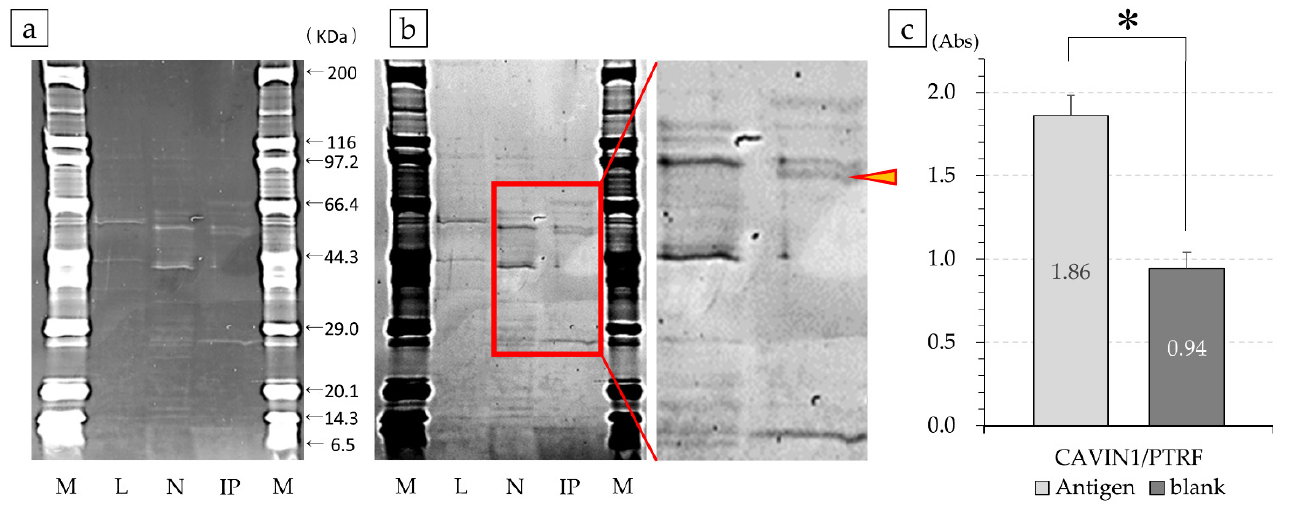
Figure 5. SDS-PAGE of the antigen–antibody complex and confirmation analysis with purified protein. Using immunoprecipitation through magnetic beads, the band incubated separately with the antibody was detected. Number 12 ( a ); M, marker; L, cell lysate solution; N, negative; IP, positive samples recovered by immunoprecipitation. Figure 5a is inverted in black and white and shows an enlarged view of more specific bands. This band (yellow arrowhead) was analyzed by Liquid chromatography-mass spectrometry (LC/MS) ( b ). The reactivity of commercially available CAVIN1/PTRF with antibody number 12 was confirmed. The protein had a stronger reactivity with the purified protein compared to that with the negative control, suggesting the occurrence of an antigen–antibody reaction (* p < 0.001) ( c ).